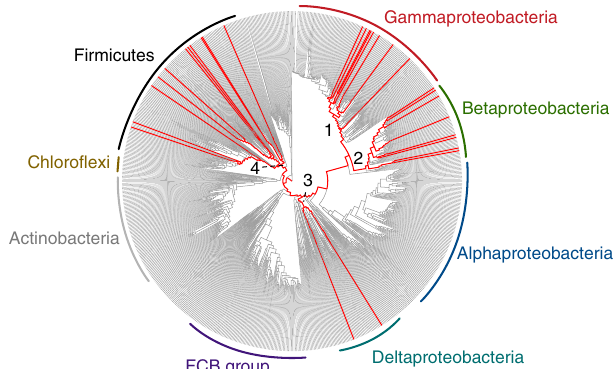
Fig. 2 Phylogenomic distribution of proteolytic fl agellins on bacterial tree of life. Genera with predicted proteolytic fl agellin genes are indicated by red lines . The presence/absence pattern is highly scattered indicative of